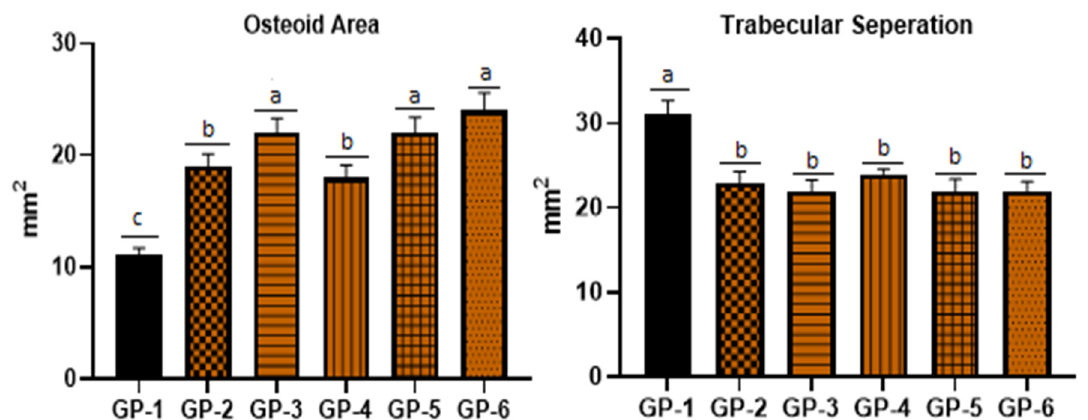
Figure 4. Histomorphometric difference in osteoid area and trabecular separation among group fed on vitamin D deficient (GP-1), shiitake (GP-2), button (GP-3), oyster (GP-4), vitamin D 2 (GP-5) and vitamin D 3 (GP-6). Values are presented as mean ± SD for n = 6. The experimental values within any specific group that do not have a common superscript are significantly different ( p < 0.05) based on Tukey’s post hoc test .